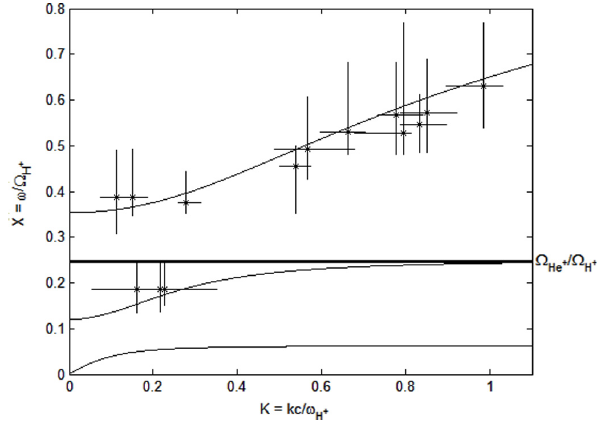
Fig. 6. Frequency vs. wavenumber relation plot of wave packets observed during the event. The bold line marks the helium ion gy- rofrequency. The crosses signify individual wave packet observa- tions overplotted with error bars in frequency and wavenumber. The solid curves are different branches of the cold plasma dispersion re- lation for the aforementioned plasma